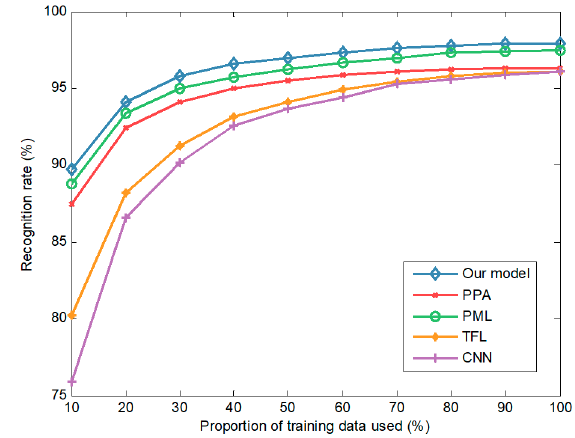
Figure 5. The recognition rates obtained from different amounts of training data.